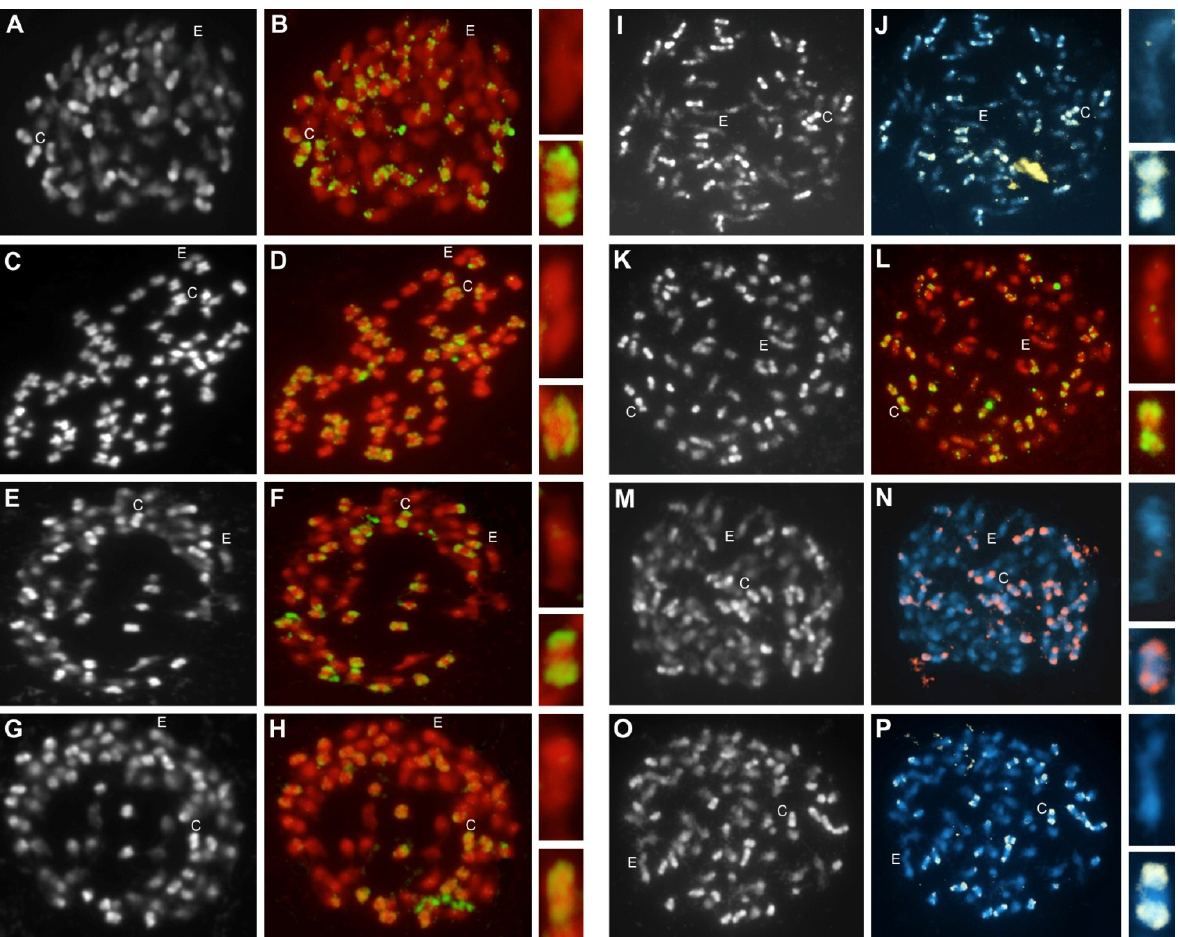
Figure 2. Main results from genomic in situ hybridization (GISH) experiments. Hybridization signals and patterns obtained using S. alba as probe and S. fragilis as template (panels A-D) and S. fragilis as probe and S. alba as template (panels E-H). Hybridization signals and patterns obtained using S. alba as probe and interspecific hybrid as template (panels I-L) and S. fragilis as probe and interspecific hybrid as template (panels M-P). Both male and female S. alba and S. fragilis accessions are the parental genotypes used for S. alba × S. fragilis and S. fragilis × S. alba crosses, whereas interspecific hybrids refer to two intermediate F1 progeny genotypes. Note the great variation of genomic in situ hybridization signals and patterns in contracted ( i . e . large spots) and extended ( i . e . small dots) chromosomes across all experiments. Magnifications of specific contracted (C) and extended (E) chromosomes are reported for each GISH-derived